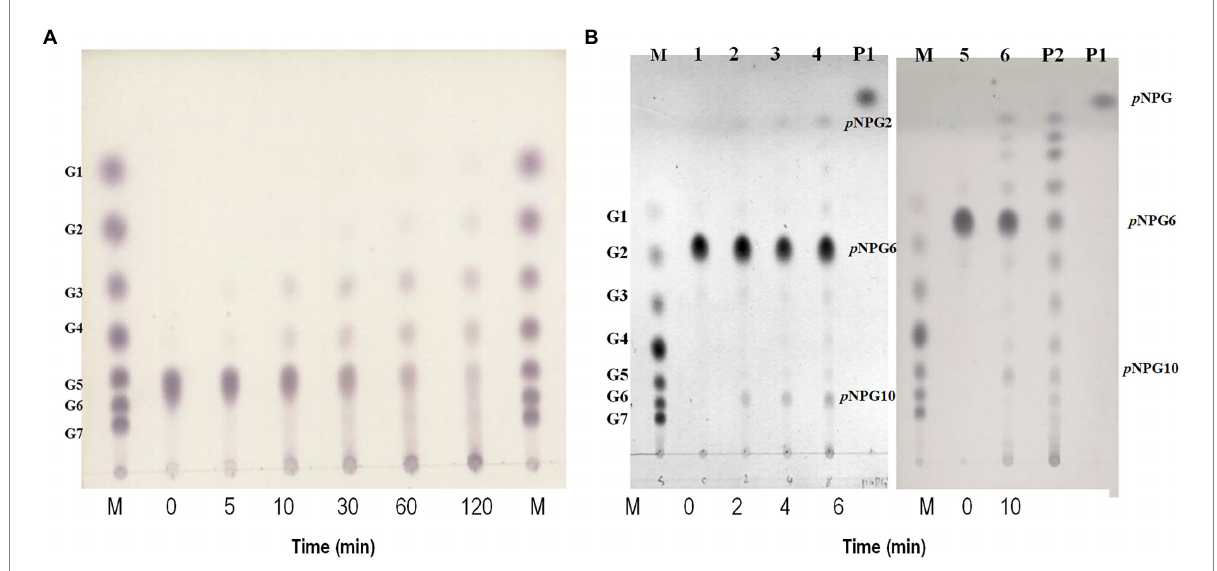
FIGURE 4 Hydrolytic action of rPSGT. (A) Time course analysis of disproportionation reaction pattern of rPSGT in the presence of maltopentaose. Reaction mixtures were incubated with 10 mM maltopentaose at 85 ° C for 0–120 min. (B) Hydrolytic action of rPSGT on 10 mM p NPG6. Reaction with 0.097 mg/ml rPSGT at 85 ° C for various time intervals (2–10 min). Lane M, G1–G7 standard; Lane P1, p NPG standard; and Lane P2, p NPG2-10 standard.